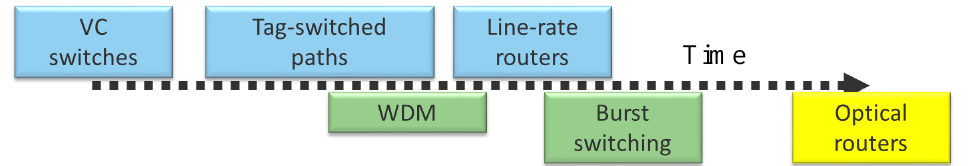
Figure 1. Evolution of electronic channel sharing ( top ) and optical channel sharing ( bottom ).